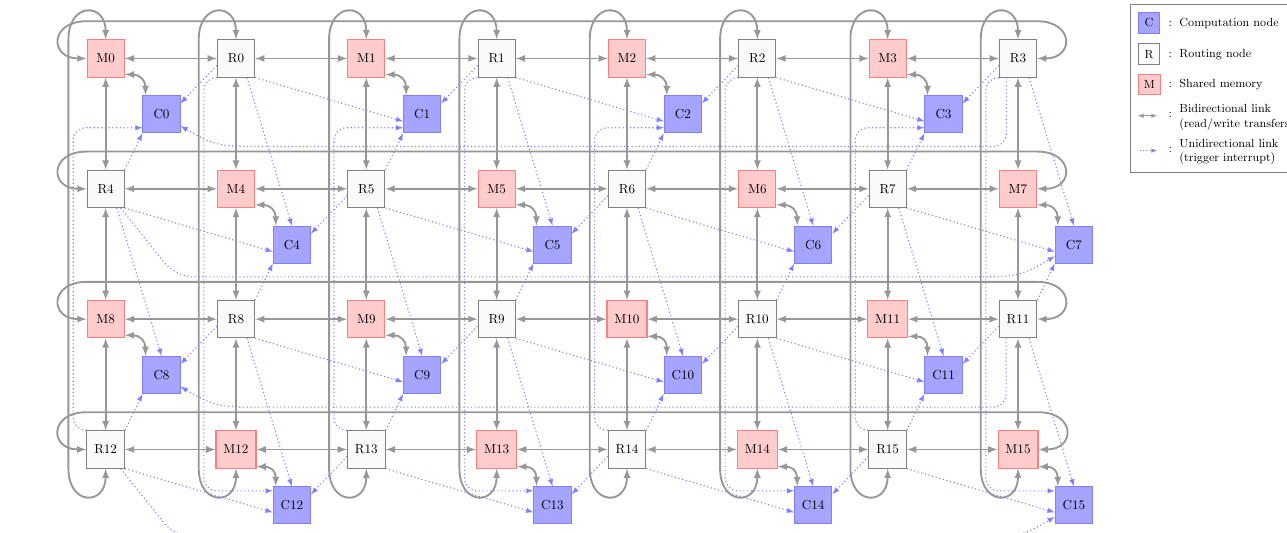
Figure 1: 4 × 4 torus-2D architecture with routing and computing nodes as well as notification of computation cores using interrupts if new data have arrived.